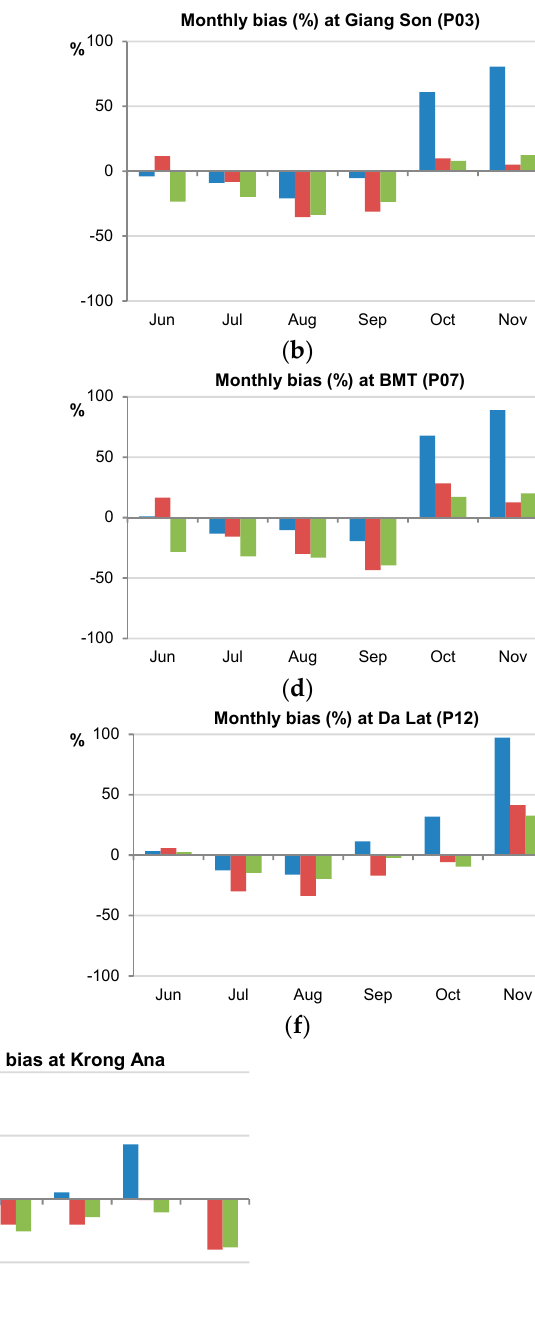
Figure 5. Monthly bias (%) of different SBRP data sets compared to GMP data in dry season at different stations and Krong Ana Sub-catchment: ( a ) at Krong Buk station (P01), ( b ) at Giang Son station (P03), ( c ) at Buon Ho station (P06), ( d ) at BMT station (P07), ( e ) at M'Drak station (P09), ( f ) at Dat Lat station (P12), and ( g ) at Krong Ana Sub-catchment.